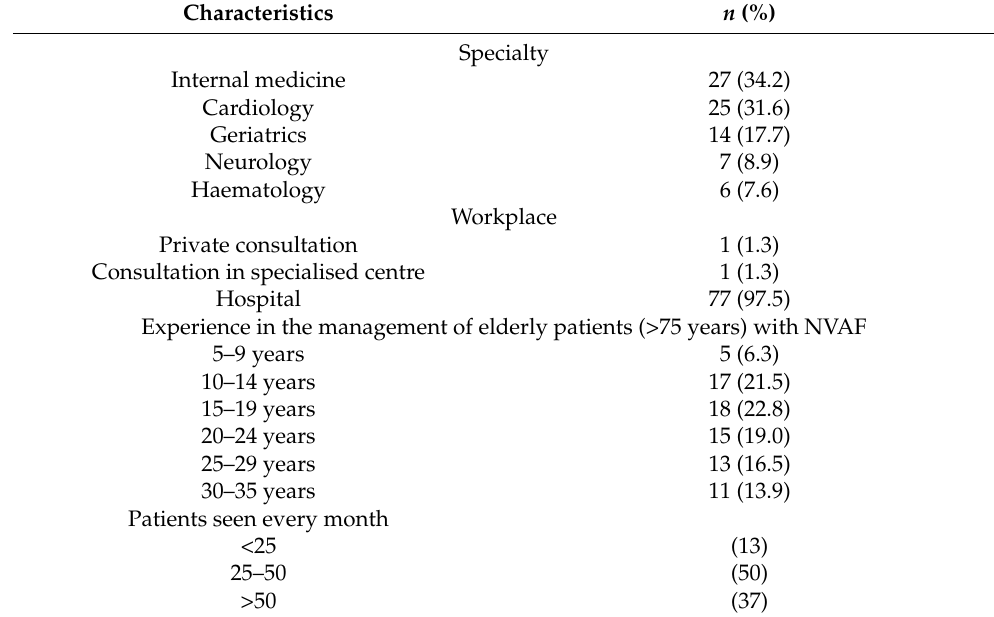
Table 1. Panellist characteristics ( n =